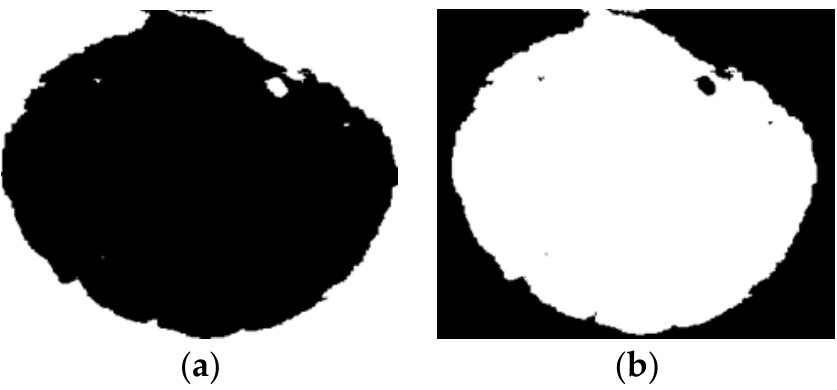
as shown in Figure 10b.